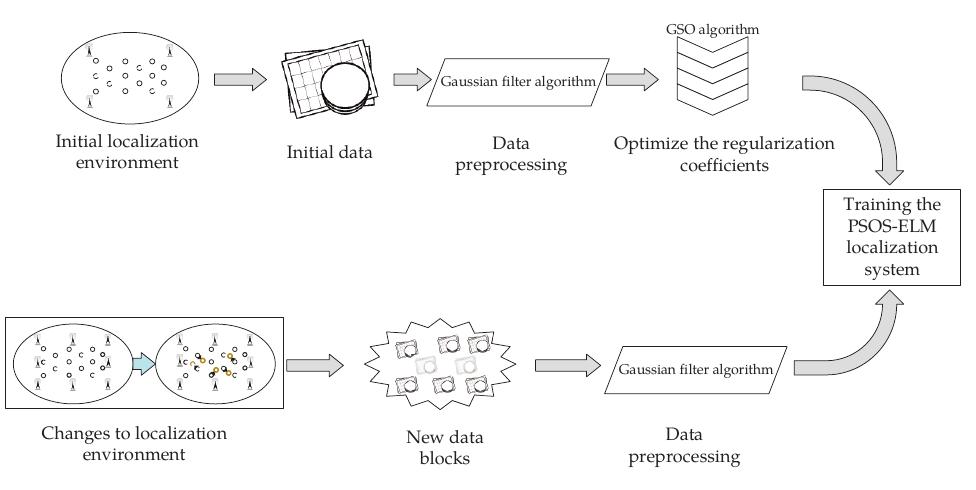
Figure 7. The Steps to Process the Dynamic Changes.